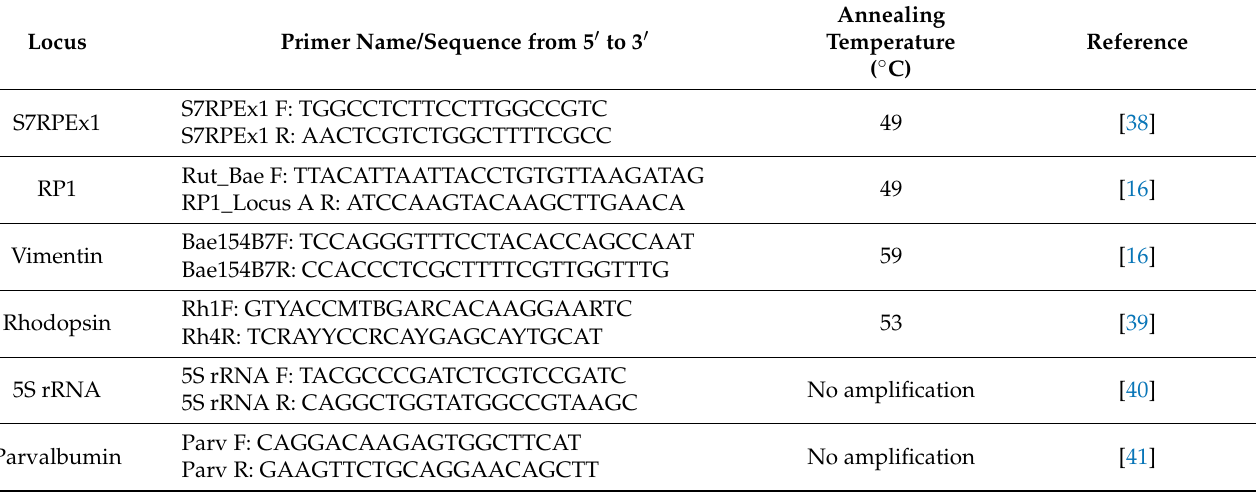
Table 3. Nuclear gene loci analyzed in the